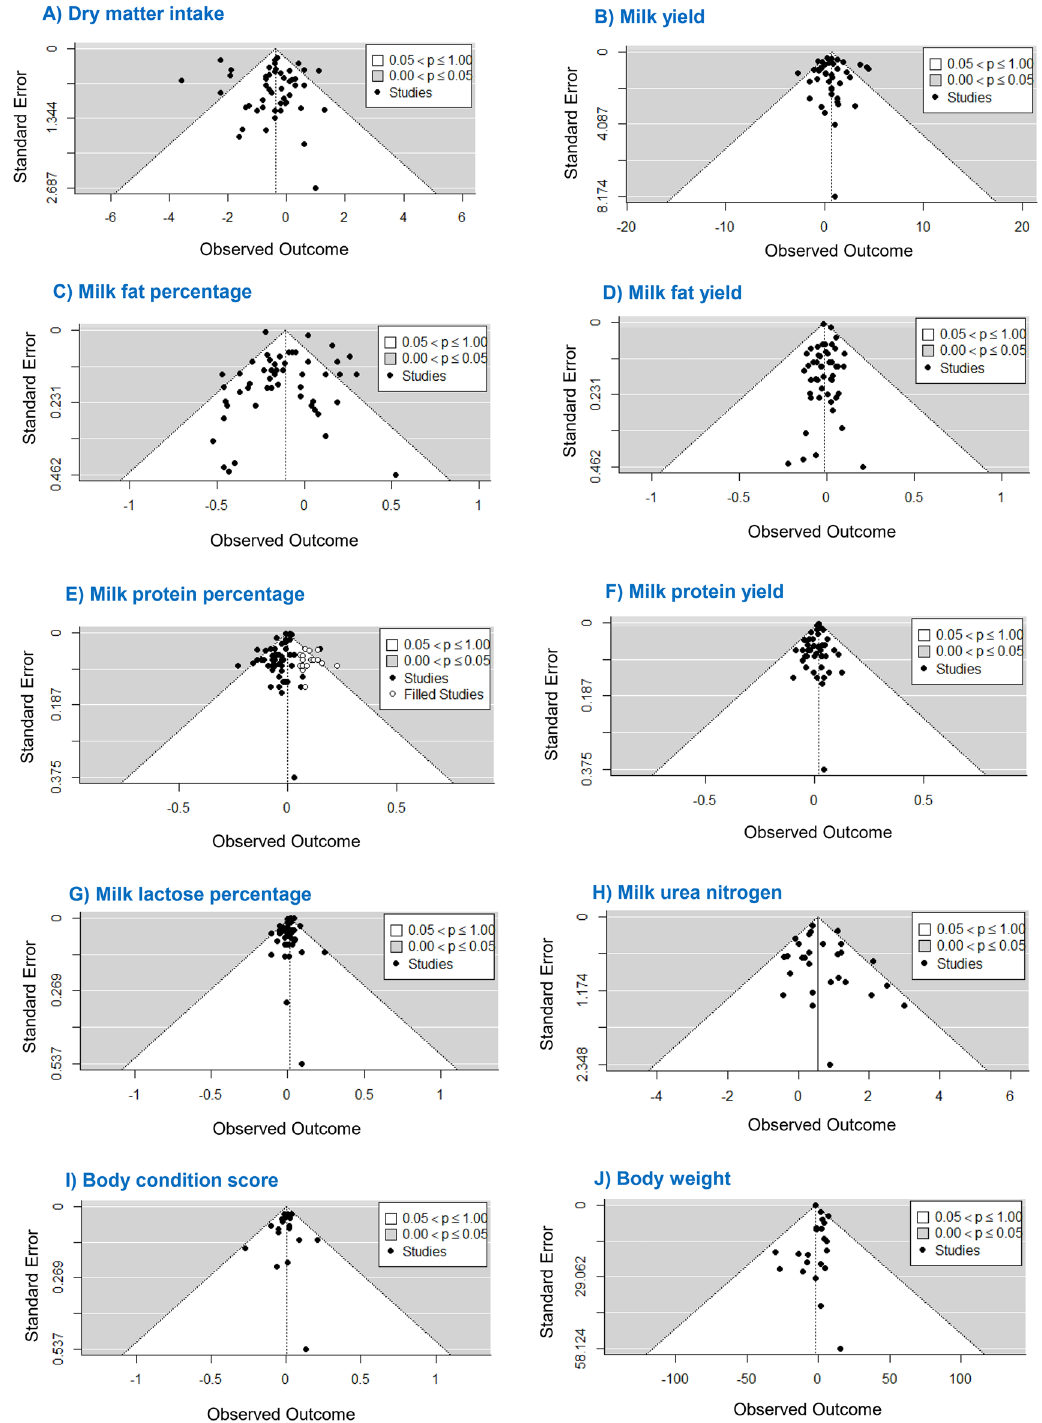
Figure 4. Contour-enhanced funnel plots of studies investigating the association between monensin supplementation and ( A ) dry matter intake (kg/day), ( B ) milk yield (kg/day), ( C ) milk fat percentage, ( D ) milk fat yield (kg/day), ( E ) milk protein percentage, ( F ) milk protein yield (kg/day), ( I ) milk lactose percentage, ( G ) milk urea nitrogen (mg/dL), ( K ) body condition score, and ( L ) body weight (kg). Dotted lines represent 95% pseudo-confidence interval. SE standard